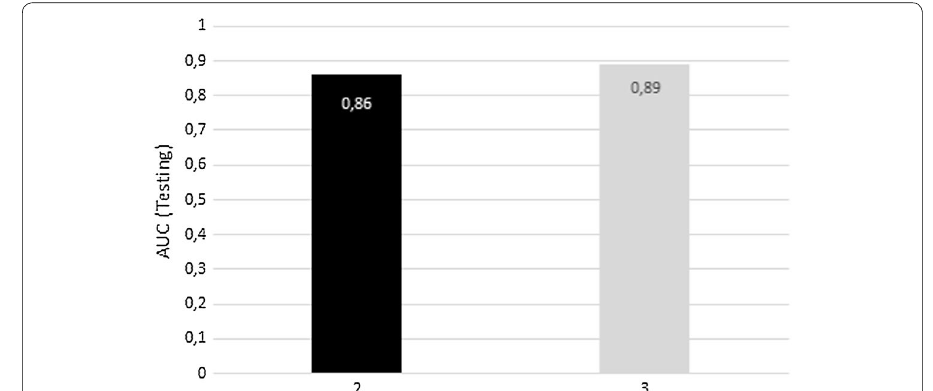
Fig. 4 Final testing with deep neural network: AUC